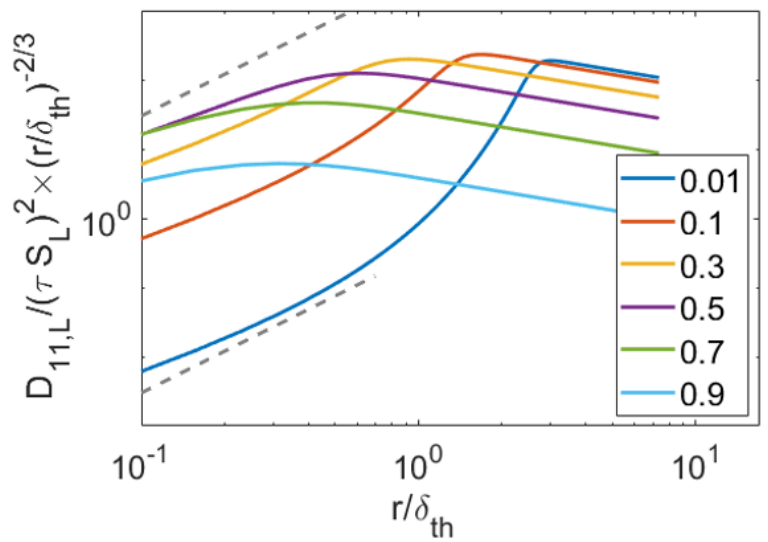
( r / δ th ) − 2/3 with r / δ th for a laminar 1D flame for SFs starting from D 11, L / ( τ S L ) 2 Figure 4. Variations { } different c values. The analytic r 2 scaling is shown by grey dashed